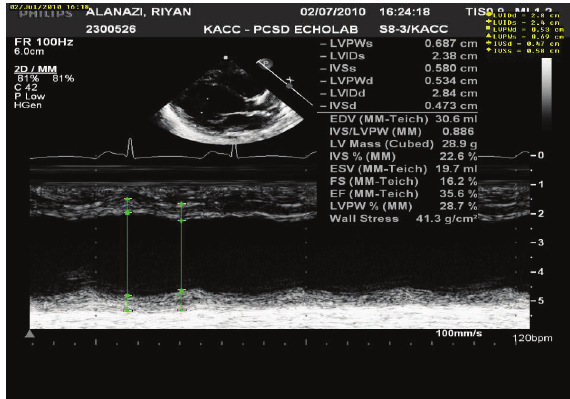
Figure 1: Echo for the patient showed depressed myocardiac function with ejection fraction